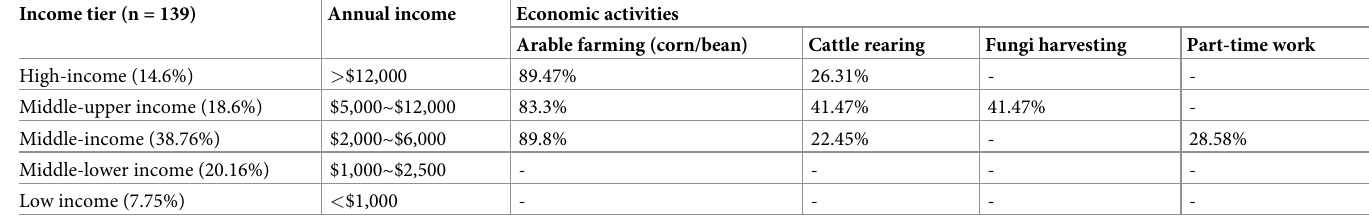
Table 1. Annual income and economy activities in the survey area. The ratio under each economy activity indicates the proportion of respondents who engage in these economic activities, with the majority of households involved in several different economic activities concurrently. The main income sources reported for the two